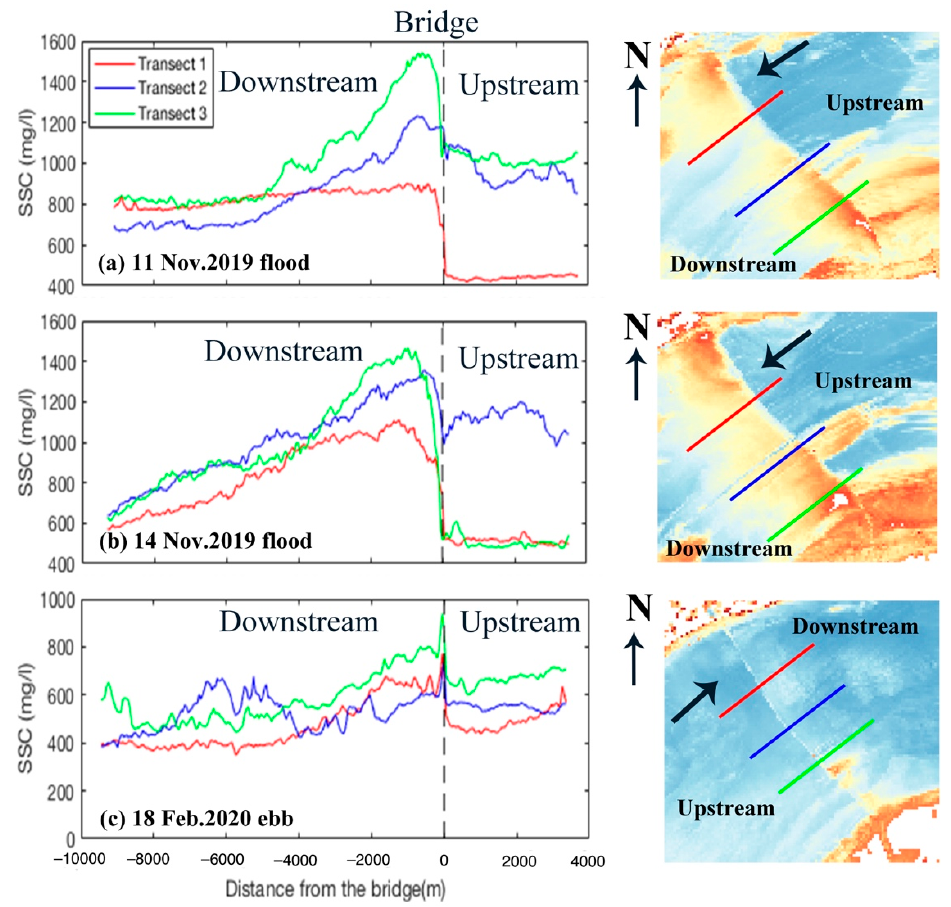
Figure 9. Suspended sediment concentration (SSC along transects obtained from HY-1C on 11 November 2019 ( a ), 14 November 2019 ( b ) and 18 February 2020 ( c ). The vertical black dashed line on the left figure denotes the bridge, and the black arrow pointing to the bridge on the right figure denotes the current direction.